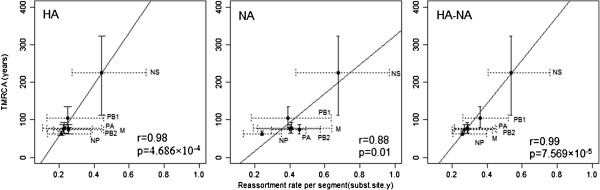
Correlation between TMRCA (years) and reassortment rate (exchanges per year). For HA subtype, NA subtype and HA-NA combined subtype, respectively. Scatterplots of mean TMRCA (95% HPD intervals were shown in solid vertical lines) against the mean reassortment rate (95% HPD intervals shown in dotted horizontal lines) of each internal segment. The related segment names were labelled alongside.